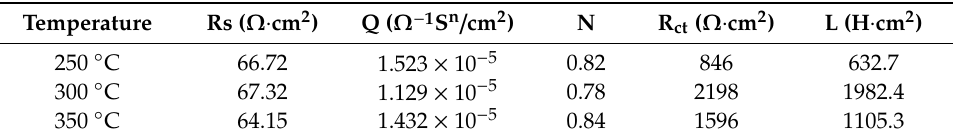
Table 4. Fitting results obtained from the EIS spectra of extruded alloys.